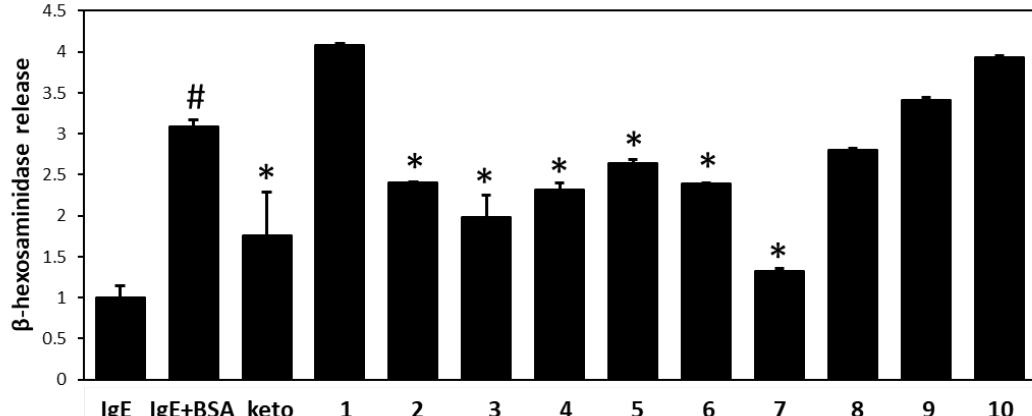
Figure 3. Anti-allergic effects of the ten flavonoids isolated from W. dolichantha on β -hexosaminidase release from IgE-mediated RBL-2H3 cells. Results are expressed as the means ± SDs of two independent experiments. # p < 0.05 vs. vehicle control; * p < 0.05 vs. IgE + DNP-BSA treated cells. IgE = vehicle control, IgE + BSA = IgE + DNP-BSA treated cells, keto = 30 μ M ketotifene.